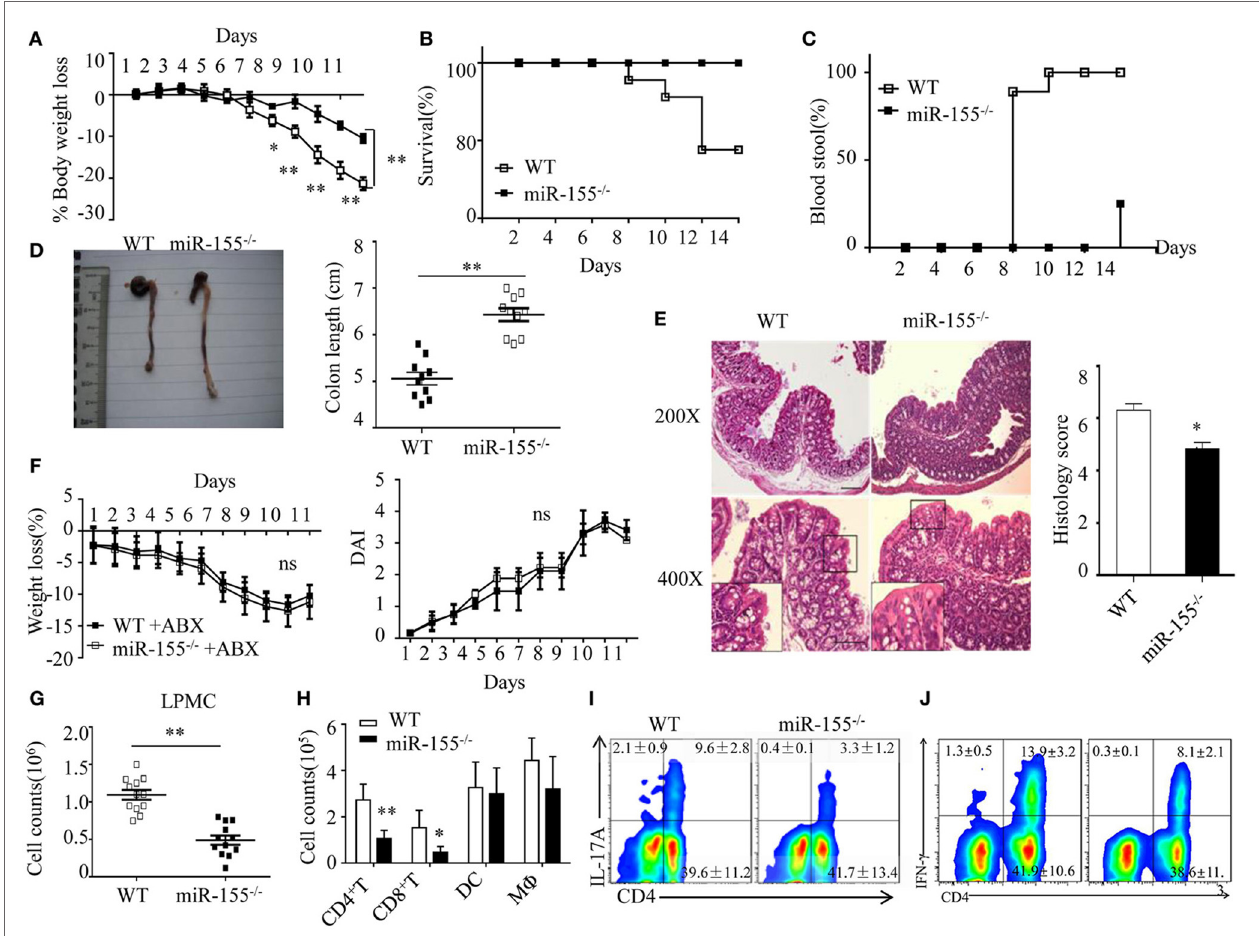
FigUre 1 | Attenuated dextran sulfate sodium (DSS)-induced colitis in miR-155 − / − mice is dependent on commensal bacteria. WT or miR-155 − / − mice were given 3% DSS in drinking water for 5 days, followed by regular drinking water for 6 days. (a–e) Weight change (a) , Kaplan–Meier plot of survival rate (B) , stool blood (c) , representative gross colon appearance [ (D) left] and colon length [ (D) right], and representative H&E-stained colon cross-sections [ (e) left, original magnification, 200 × or 400 × ] and semi-quantitative histopathology score [ (e) right]. (F) WT and miR-155 − / − mice were treated with broad-spectrum antibiotics cocktail (ABX) for 4 weeks and then given 3% DSS, the body weight change (left) and DAI (right) were monitored daily. Ns vs WT control (g,h) . The LPMCs were isolated from colon tissues of DSS-treated WT ( n = 12) and miR-155 − / − ( n = 15) mice, then the total number of LPMCs (CD45 + ) (g) , T cells (CD4 + and CD8 + ), DCs (CD11c + CD11b − ) and macrophages (CD11b + CD11c − /low ) (h) were counted by flow cytometry. (i,J) Representative FACS showing CD4 + IL-17 + cells (i) and CD4 + IFN- γ + cells (J) in isolated LPMCs of DSS-treated WT ( n = 12) and miR-155 − / − ( n = 15) mice. * P < 0.05, ** P < 0.01 vs WT control [Student’s t -test in (a,D,e,g,h) and Kaplan–Meier analysis in (B,c) ]. ns vs WT control. Data are representative of three independent experiments (mean and SD in A-D); n = 12–15 mice per group in (a–F) and n = 5–6 mice per group in (g) . ns, not significant. WT,